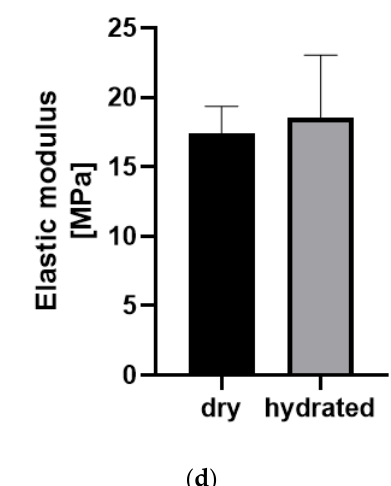
Figure 6. ( a ) Stress versus strain curve of BMSF/PCL hydrated (black continuous line) and dry (dotted orange line) scaffolds under tensile test; ( b ) failure stress of dry (black column) and hydrated (grey column) scaffolds; ( c ) failure strain of dry (black column) and hydrated (grey column) scaffolds; ( d ) elastic modulus (E) of dry (black column) and hydrated (grey column) scaffolds.